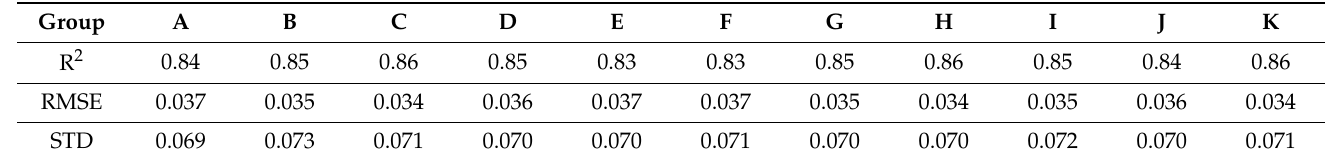
Figure 9. Taylor diagram of the comparison of the RF mapped and observed soil moisture. A (LST, NDVI), B (LST, TVDI), C (LST, SEE), D (NDVI, TVDI), E (NDVI, SEE), F (TVDI, SEE), G (LST, NDVI, TVDI), H (LST, NDVI, SEE), I (LST, TVDI, SEE), J (NDVI, TVDI, SEE), and K (LST, NDVI, TVDI, SEE). Table 2. The coefficient of determination (R 2 ), root mean square errors (RMSE), and standard deviations (STD) between RF results by each multiple auxiliary variables combination and observed soil